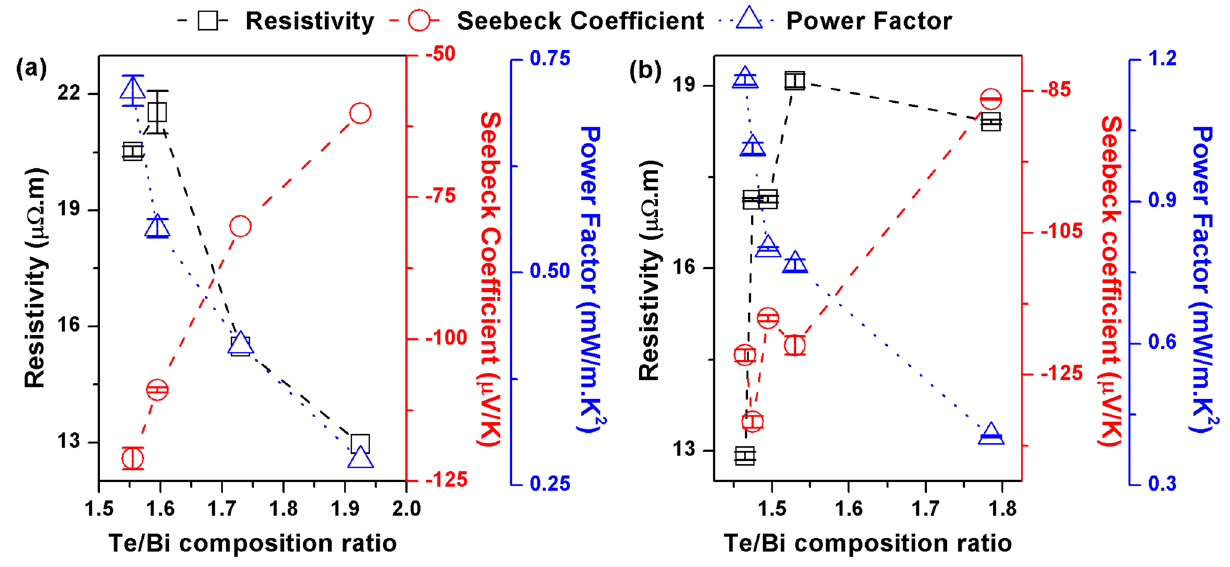
Figure 6. The electrical resistivity, Seebeck coefficient and power factor (PF) of the Bi–Te thin films prepared at high substrate temperatures: ( a ) with adhesion layer and ( b ) without adhesion